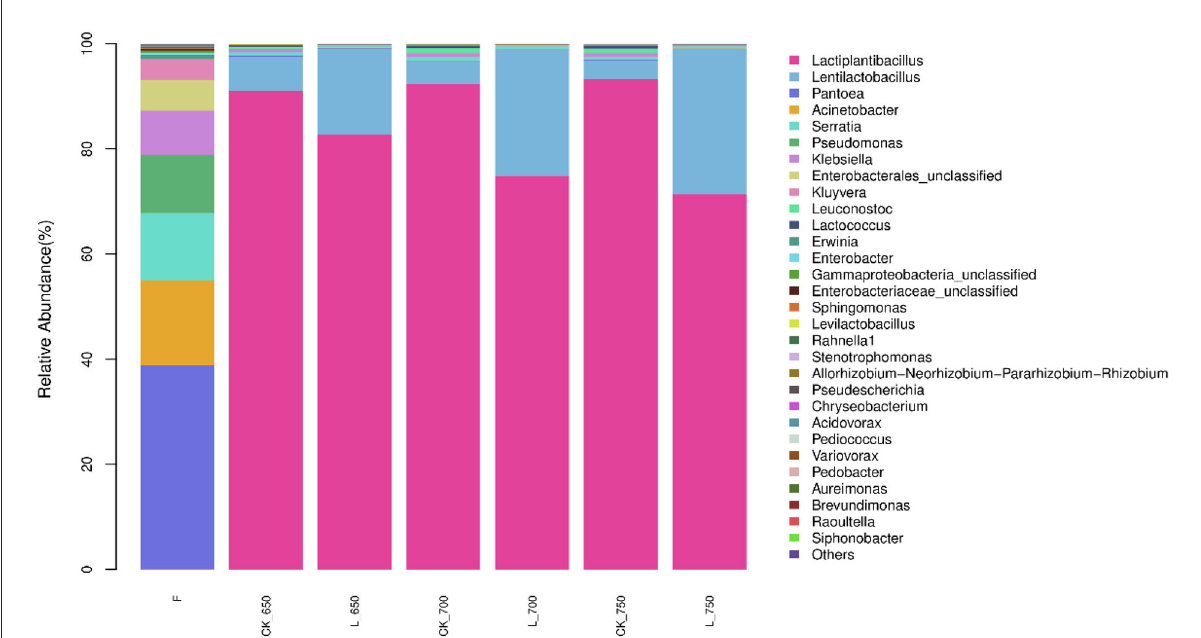
FIGURE2 Relative abundance of bacterial community (genus level) in sweet sorghum silages ( n = 4). CK, ensiling of sweet sorghum with 2.00 mL/kg fresh weight (FW) of distilled water at 650 (CK_650), 700 (CK_700), and 750 kg/m 3 (CK_750) of density, respectively; L, ensiling of sweet sorghum with 2.00 g/t FW of lactic acid bacteria (LAB) inoculant and 2.00 mL/kg FW of distilled water at 650 (L_650), 700 (L_700), and 750 kg/m 3 (L_750) of density,